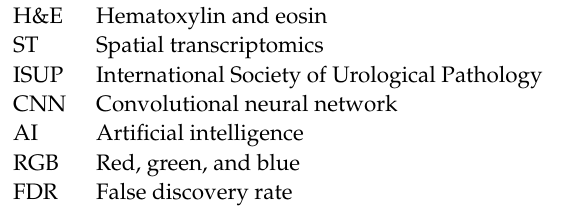
benign. Figure S2. Complete annotations for section 2, PIN = prostatic intraepithelial neoplasia. Figure S3. Complete annotations for section 3, PIN = prostatic intraepithelial neoplasia. Figure S4. Complete annotations for section 4, PIN = prostatic intraepithelial neoplasia. Figure S5. Complete annotations for section 5. Figure S6. Complete annotations for section 6. Figure S7. Complete annotations for section 7. Figure S8. More than 10 features results in redundant feature maps. If the models’ 30 × 10 = 300 features are reduced to 20 dimensions, many of the maps are redundant; some of them are negatives or linear combinations of others, meaning that they would not contribute to new clusters, but rather confirm already found clusters. Figure S9. Comparison of clustering 10 UMAP components into 5 clusters using different algorithms for section 5. Figure S10. Comparison of morphology and gene factors in Sections 1–4, 6 and 7. Figure S11. Comparison with ImageNet pre-trained network. Figure S12. Scatter plots of the normalized expression for all genes appearing in Figure 4 and their corresponding morphological